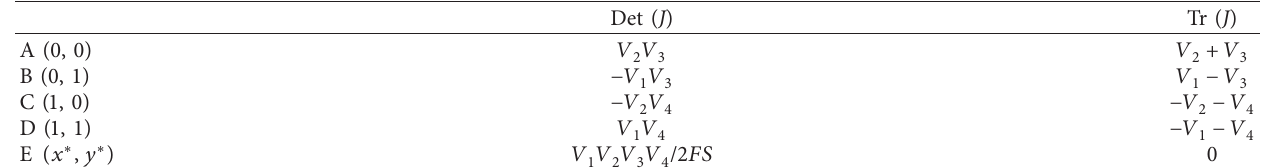
Table 4: The simplified determinant and trace of partial equilibrium points.